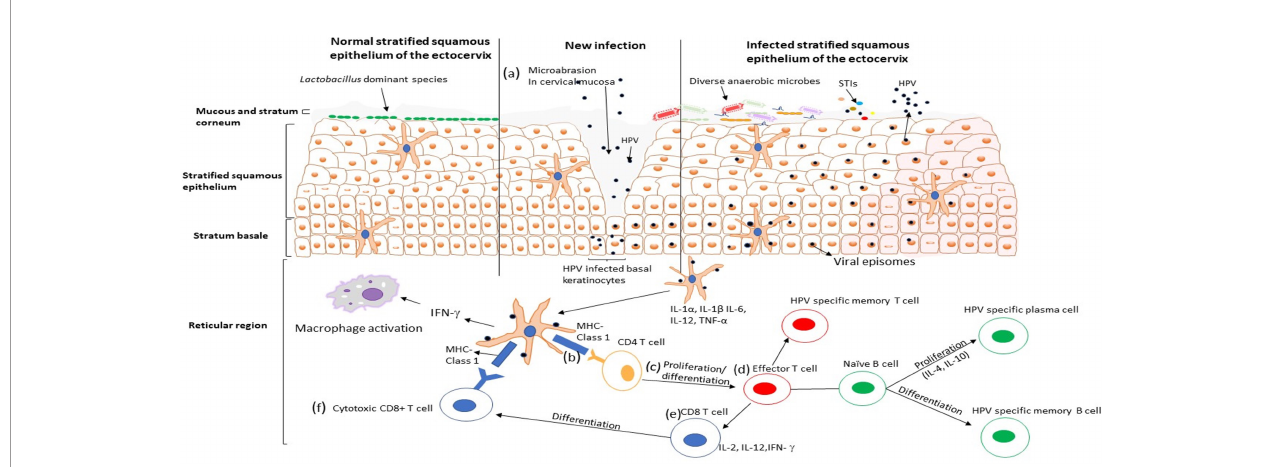
FIGURE 1 | HPV infection cycle in the ectocervix of the female genital tract. (A) The HPV virus particles penetrate the strati fi ed squamous epithelium through microabrasion. The virus particles infect the basal keratinocytes in the basement membrane and establish an infection, viral replication occurs, and the infected cells are transported up the epithelium. (B) Viral particles are taken up by dendritic cells that secrete T cells attracting pro-in fl ammatory cytokines and chemokines (IL-1 a , IL-1 b , IL-6, TNF- a , IL-12), which may facilitate activation and recruitment of CD4+ T cells. CD4+ T cells recognise HPV antigen presented by the dendritic cells and (C) undergoes proliferation and differentiation into the effector T cell. (D) The effort T cells [which proliferate into HPV speci fi c memory T cell and (E, F) cytotoxic CD8 + T cell] binds with the naïve B cells, which differentiate to HPV speci fi c plasma cells and HPV speci fi c memory Bcells. Activation of cellular and humoral immunity is associated with clearance of HPV